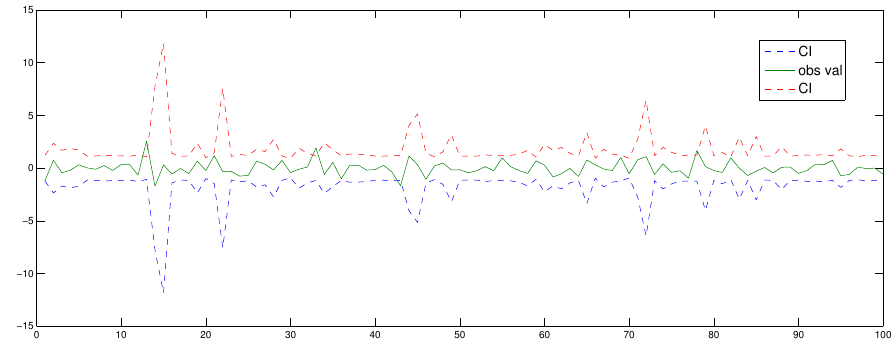
Figure 9: 95% prediction intervals for X 1 using a multivariate